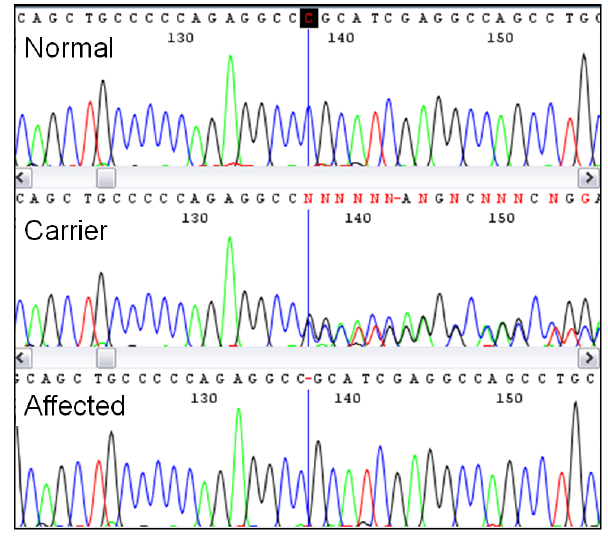
Figure 4. Discovery of the Lavender Foal Syndrome–associated single base deletion by sequencing. Pictured are aligned chromatograms from horses with each of the three genotypes. The deletion occurs at the base marked with the vertical line, causing a mixed sequence from this point forward in the carrier.